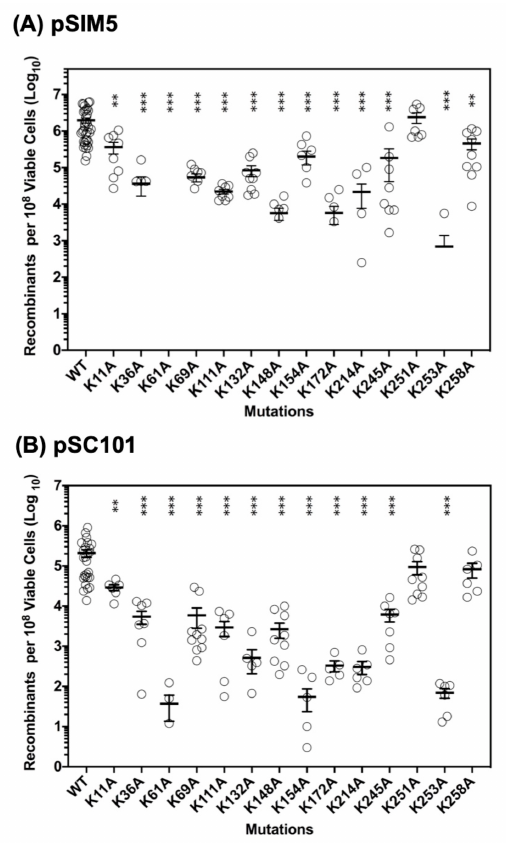
Figure 2. DNA recombination levels for the 14 Lys to Ala mutants. ( A ) Assay using pSIM5 expres- sion vector. ( B ) Assay using pSC101 expression vector. In both cases a repair oligonucleotide is electroporated into cells expressing Red proteins (including Red β ), and after recovery the cells are plated on selective media to score for recombinants, as described in Materials and Methods. The error bars show the mean +/ − SEM from a minimum of six independent measurements. Individual experiments giving no colonies (Log 10 (0) = − infinity) are not plotted, including 6/6 for K61A-pSIM5, 5/6 for K253A-pSIM5, 3/6 for K61A-pSC101, and a few others. Statistical significance (relative to WT) was assessed by unpaired two-sided Student’s T-test with Welch’s correction (** p < 0.001, *** p <